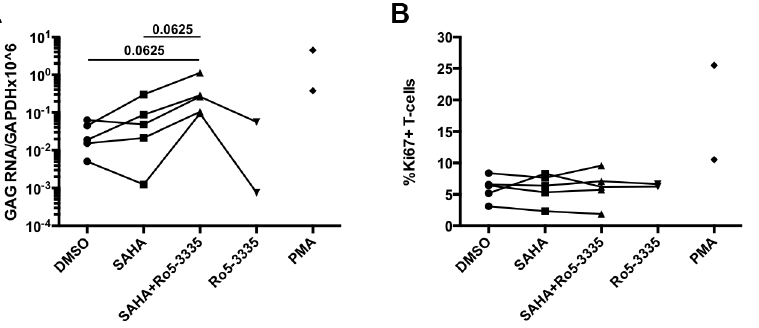
Figure 7. Ro5-3335 improves re-activation of HIV-1 in patient samples. PBMCs from HIV-1 patients suppressed on therapy were treated with DMSO, 250 nM SAHA, 5 uM Ro5-3335 or both drugs in combination. PMA treatment was used as a positive control. A ) Twenty-four hours after treatment RNA was isolated from cells and used to detect Gag mRNA by RT-qPCR. B ) Flow cytometry was used to determine the percentage of activated T-cells by staining for intracellular